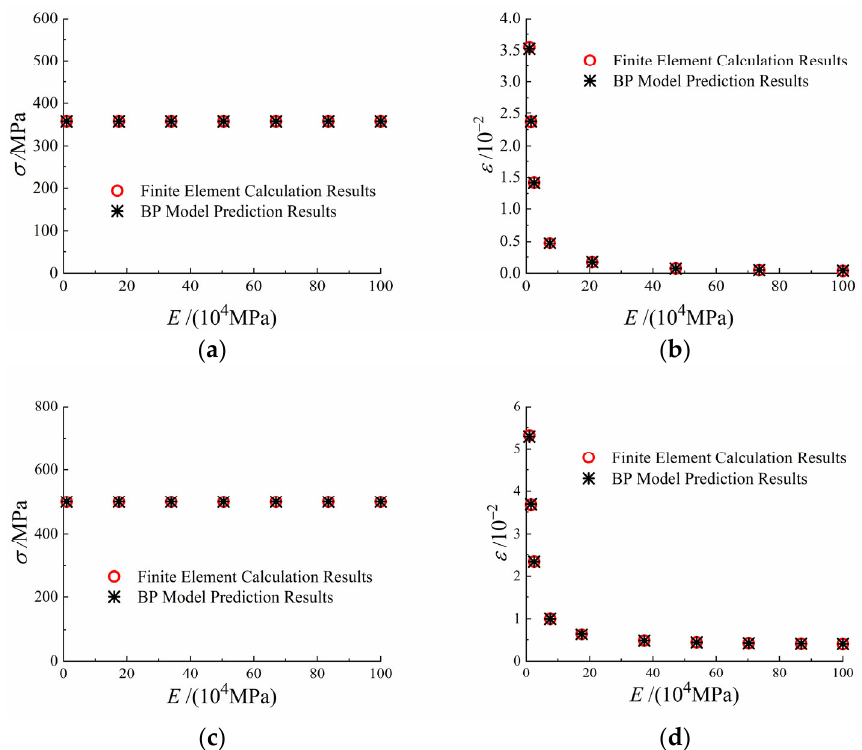
Figure 10. Model validation of change E : ( a ) elastic stage E − σ ; ( b ) elastic stage E − ε ; ( c ) plastic stage E − σ ; ( d ) plastic stage E − ε